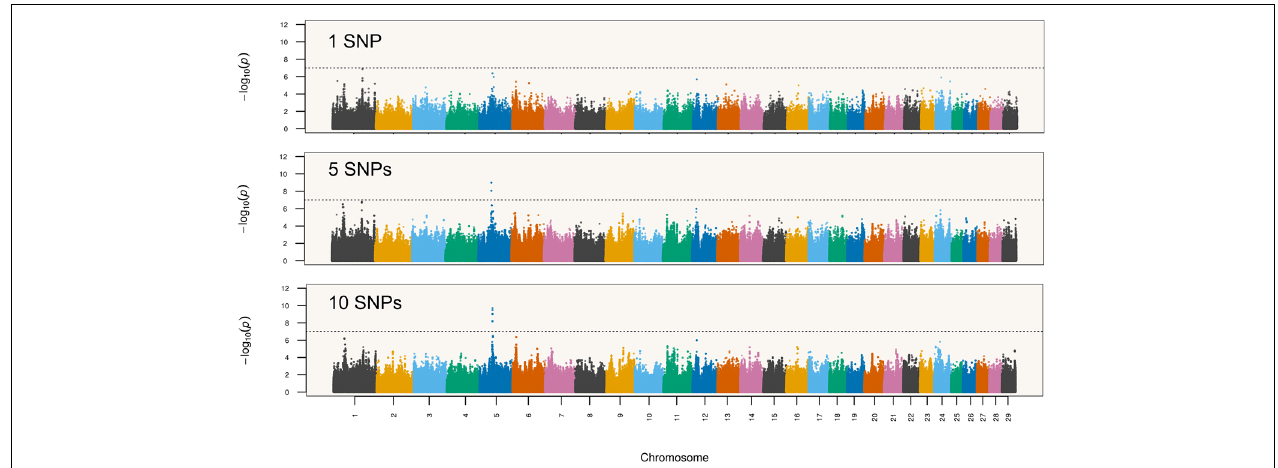
FIGURE 4 | Navel length at yearling associations with varying haplotype sizes (1, 5, and 10